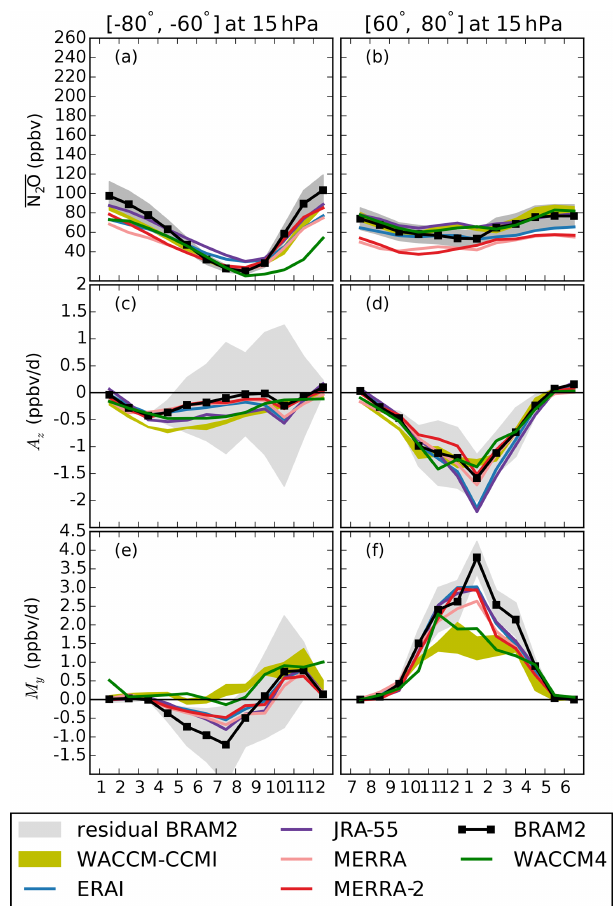
Figure 6. Annual cycles over the 2005–2014 period at 15hPa for (a, b) the N 2 O volume mixing ratio (ppbv), (c, d) M y (ppbvd − 1 ) and (e, f) A z (ppbvd − 1 ) in the (a, c, e) Antarctic region (60–80 ◦ S) and the (b, d, f) Arctic region (60–80 ◦ N). Note that the vertical scale differs for M y and A z . The olive envelope shows the three realizations of the WACCM-CCMI simulation. The color codes for the four CTM simulations follow the conventions of S-RIP (Fuji- wara et al., 2017). BRAM2 is depicted using a black line and sym- bols, as usually done for observations, because it is constrained by both dynamical and chemical observations. As the N 2 O mixing ra- tio in BRAM2 has been evaluated with a 15% uncertainty (1 σ stan- dard deviation) at 15hPa (Errera et al., 2019), this is highlighted by a dark gray region in panels (a) and (b) . The light gray shading around the BRAM2 cycles represents the uncertainty arising from the residual term in the TEM budget, i.e., it is entirely interpreted first as an uncertainty on A z and then as an uncertainty on M y in order to remain